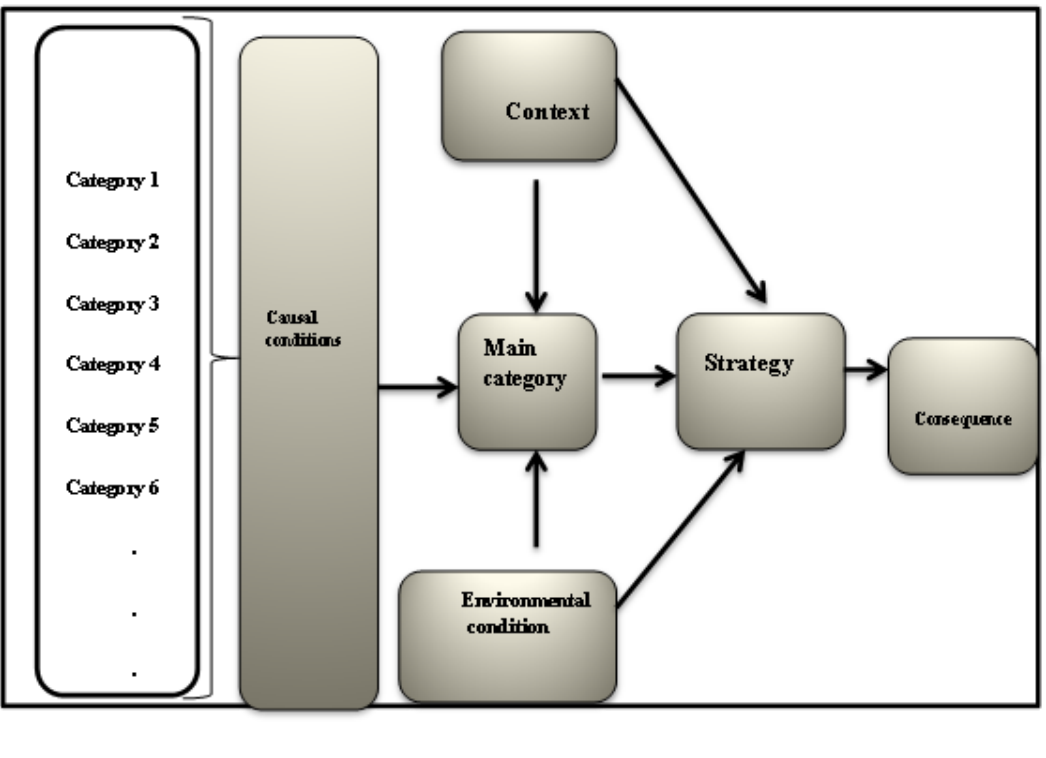
Fig. 1. Paradigm model